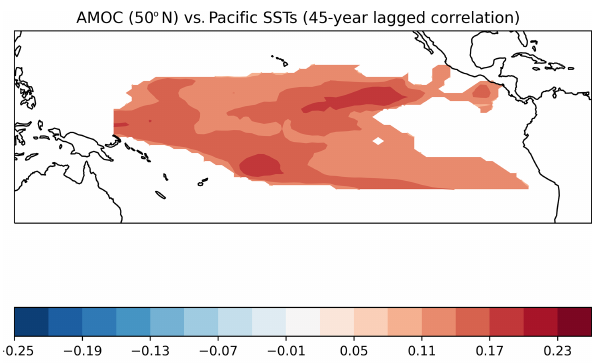
Figure 11. Correlation map of the AMOC at 50 ◦ N vs. annual equa- torial Pacific SSTs lagged by 45 years. Coloured shading indicates correlations significant to the 95% level. Both indices are smoothed with the same Gaussian filter ( σ = 2 years) as used throughout this